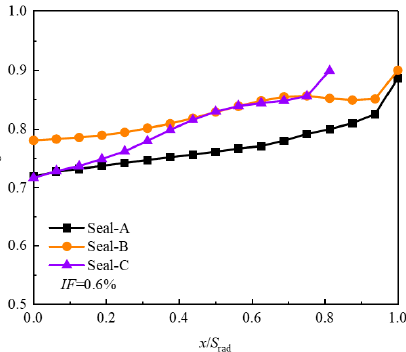
( c ) Figure 21. Time-averaged tangential and radial velocity variations along the axial direction at the middle section of the sealing cavity for IF = 0.6%: ( a ) position of the section in the middle of the sealing cavity; ( b ) time-averaged tangential velocity; and ( c ) time-averaged radial velocity. The curves of the time-averaged sealing efficiency with the axial position in the mid-